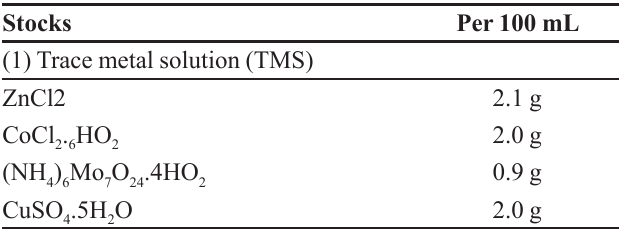
TABLE I - Walne media for cultivated N. oculata